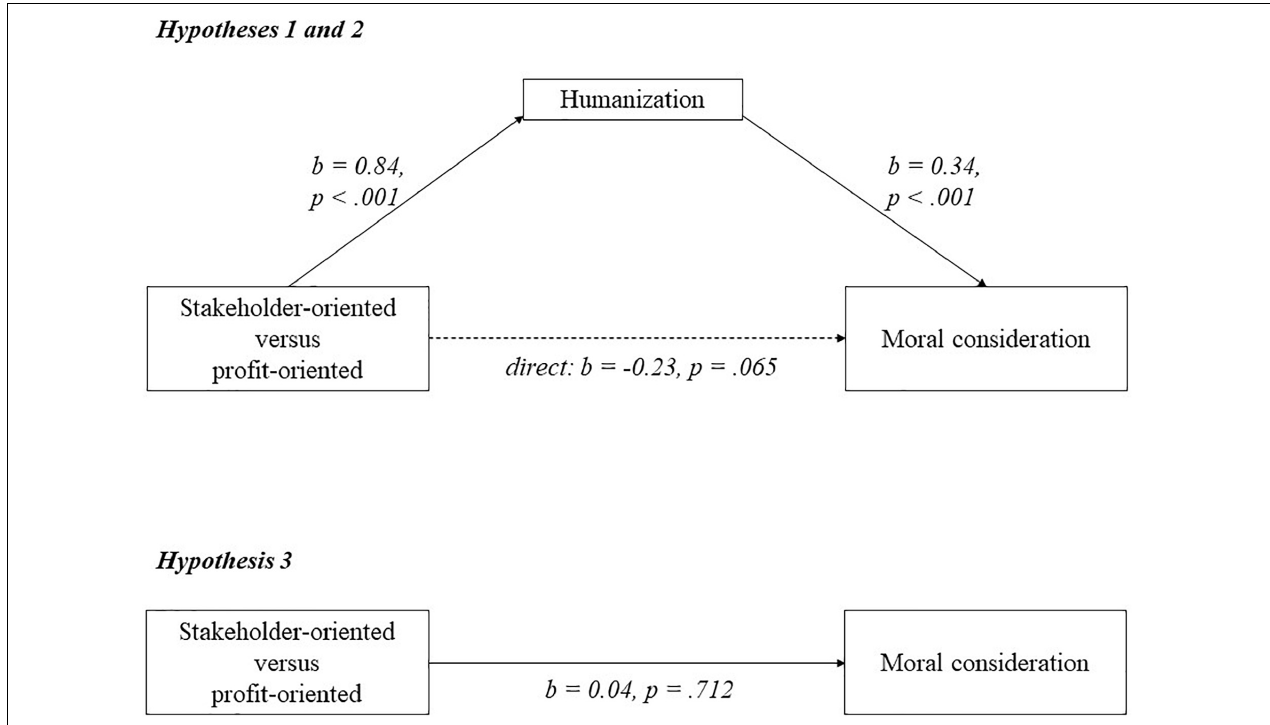
FIGURE 1 | A model of mediation indicating that the relationship between business orientation and moral consideration goes via humanization in experiment 2.